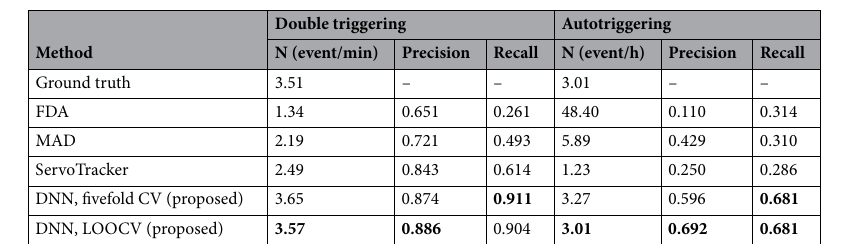
Table 3. Detection of asynchrony events. Significant values are in [bold]. FDA first derivative with adaptive threshold, MAD moving average with dynamic threshold, DNN deep neural network with local maximum, CV cross validation, LOOCV leave-one-out